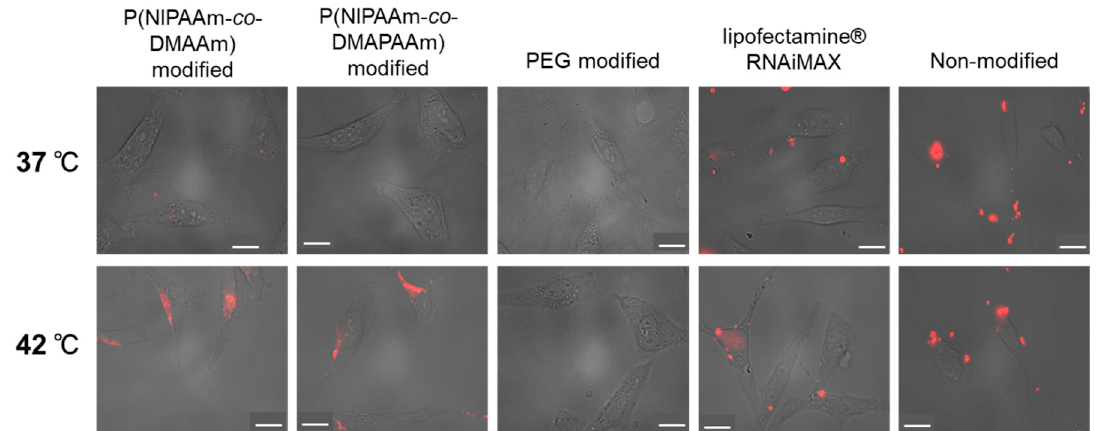
Figure 6. Cellular uptake of liposome-siRNA complex at 37 °C and 42 °C using Alexa fluor 555 labeled siRNA and luciferase expressing HeLa cells. The liposome-siRNA complex and cells were incubated for 4 h at 37 °C and 42 °C. The images were prepared by merging the phase contrast cell images and fluorescent siRNA images. The scale bar indicates 20 μ m.